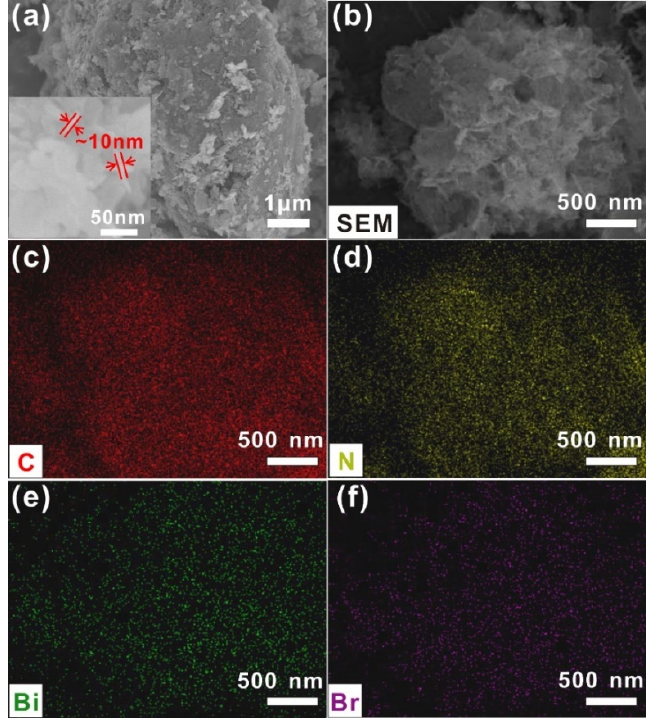
Figure 3. ( a ) SEM image (high-resolution image inset) and ( b – f ) element mapping of Bpg-C 3 N 4